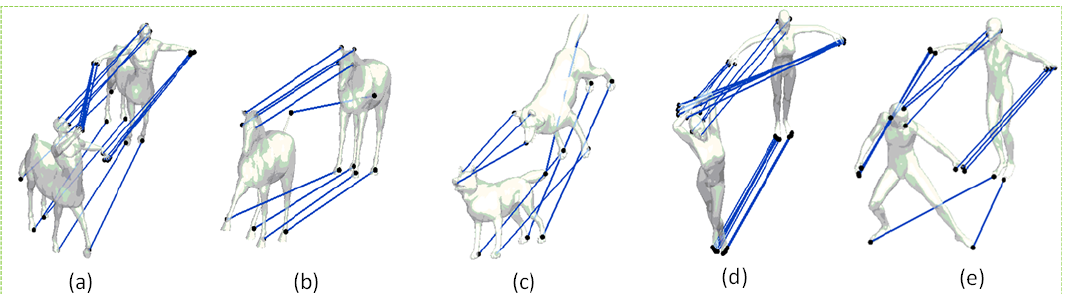
Figure 5. Application of our framework on symmetry detection (here, we just show the representative lines for visual clearness) on ( a ) human, ( b , d ) combined model, and ( c ) octopus.